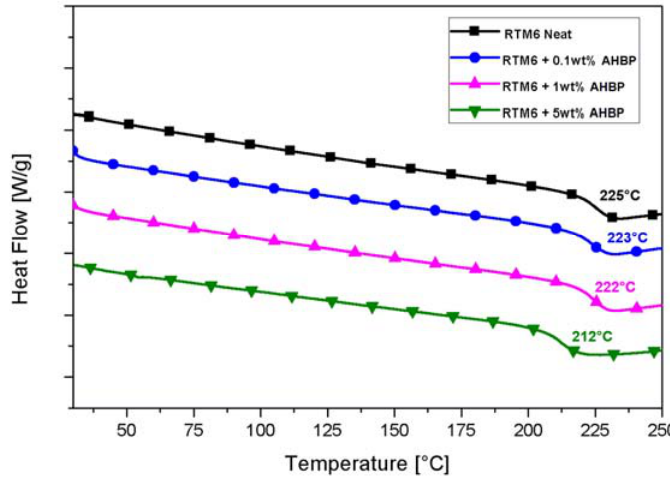
Figure 11. DSC curves of neat and filled systems.